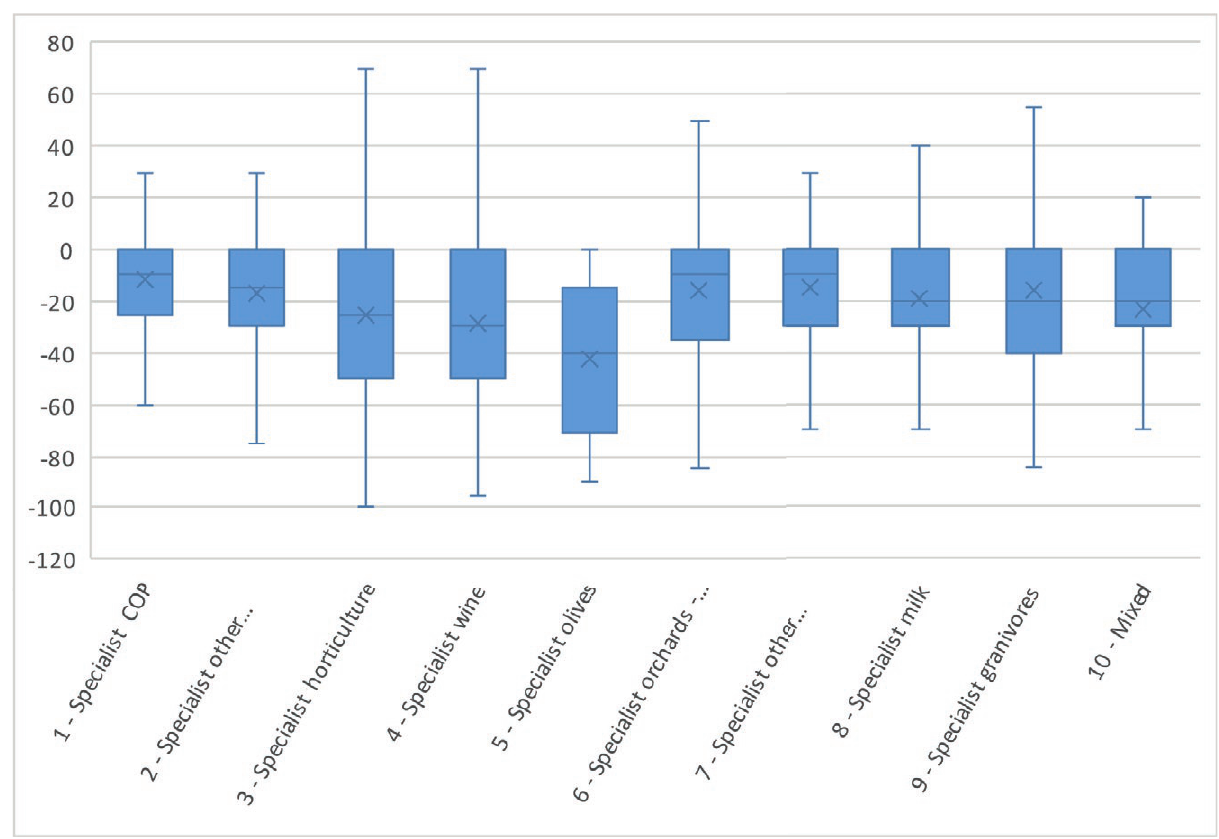
Figure 3. Expected changes in farm Total Output in relation to the diff erent Types of Farming. Source: own elaboration on collected